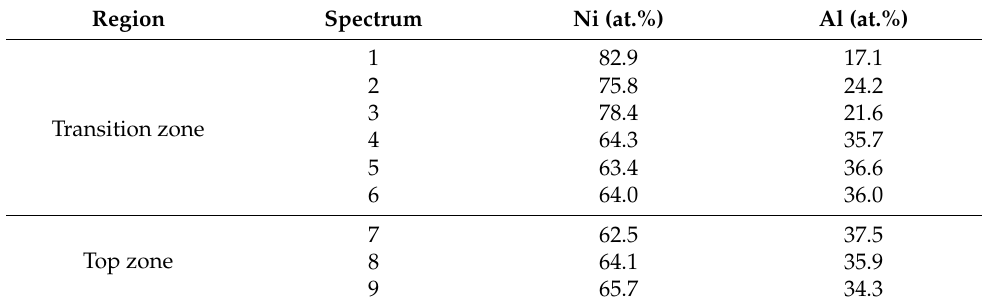
Figure 11. SEM images of a weld track deposited with parameter set 4; ( a ) overview of the weld track; ( b ) top region of weld track at 200 × magnification; ( c ) transition region from substrate to weld track at 100 × magnification with marked regions 1–5 investigated by EDX; ( d ) transition zone from substrate to weld track at 2000 × magnification with marked region 3 and 6 investigated by EDX; ( e ) top region of weld track at 1000 × magnification; ( f ) top region of weld track at 5000 × magnification with marked regions 7–9 investigated by EDX. Table 7. Regions analyzed by EDX within a single track manufactured at 900 ◦ C pre-heating temper- ature, 800 W laser power and 400 mm/min feeding speed, reference Figure